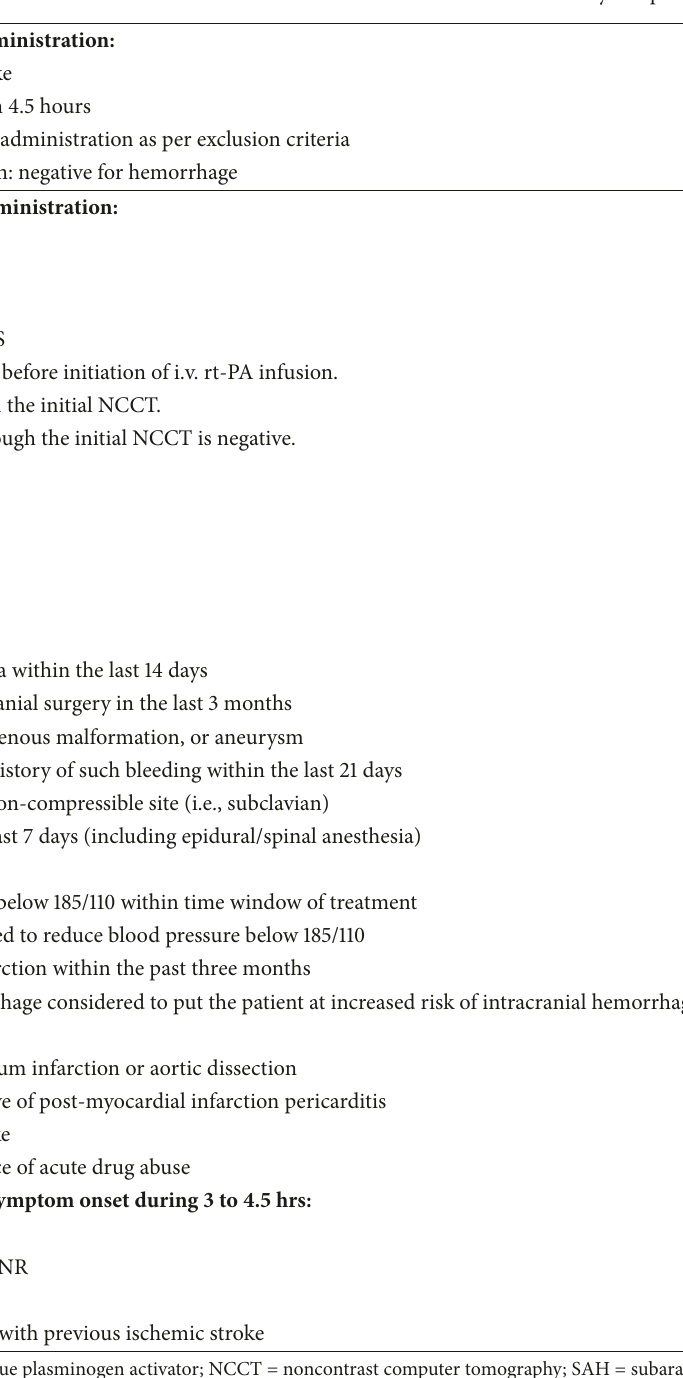
Table 1: Inclusion and exclusion criteria for i.v. rt-PA at Thammasat University